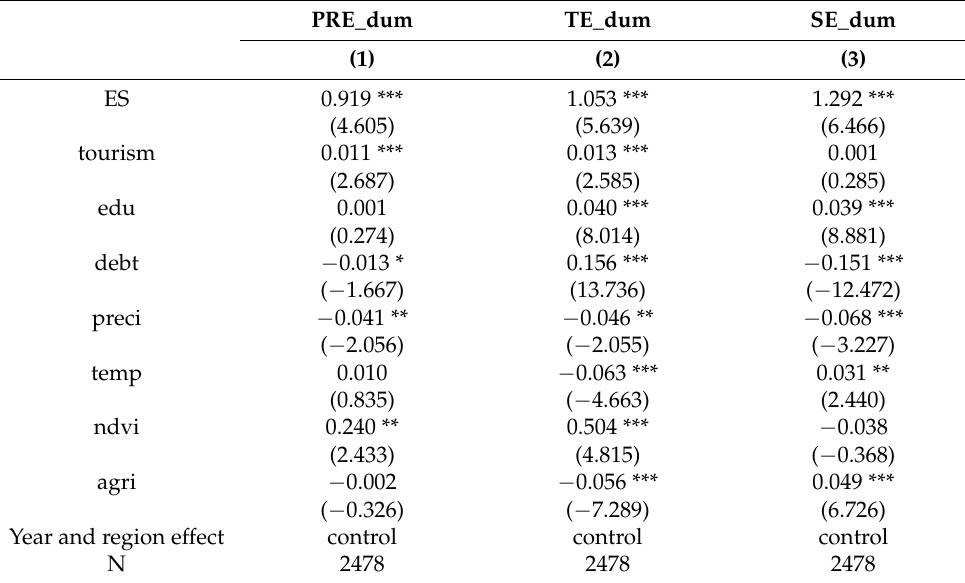
Table 4. Robustness analysis: replacing the dependent